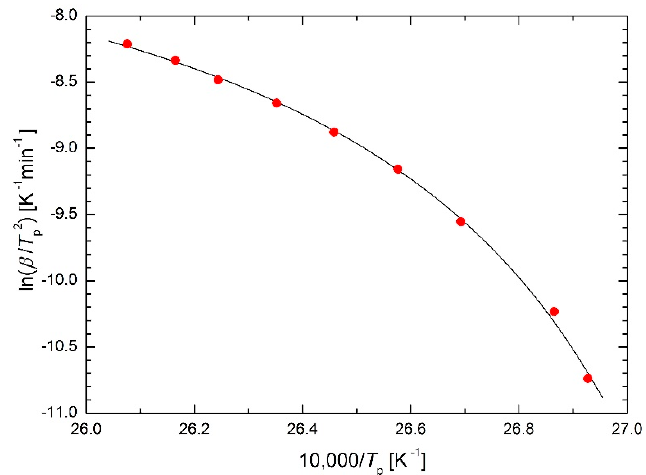
Figure 4. Kissinger plot for Ni-Mn-In-Mg shape memory alloy [5] using the modified Arrhenius Equation (23) as regression function.